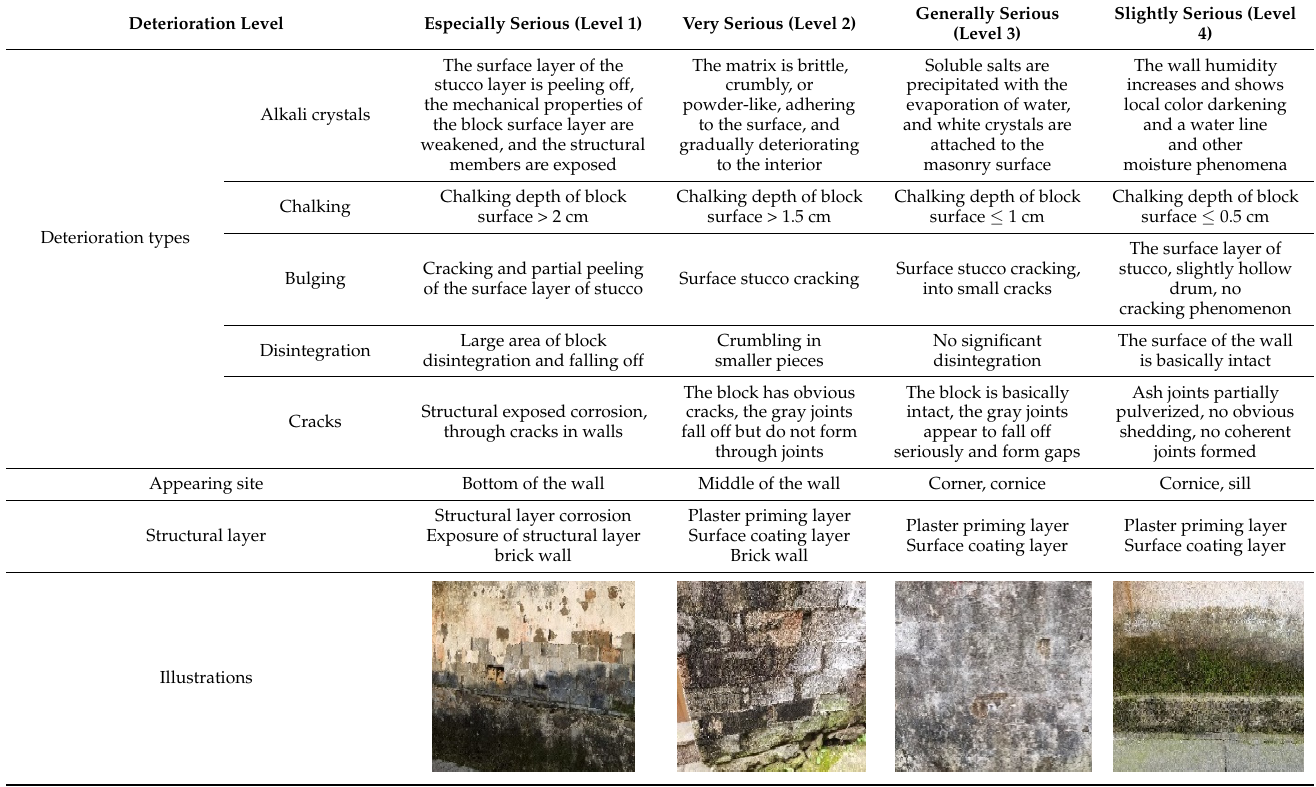
Table 2. Building deterioration level assessment classification.